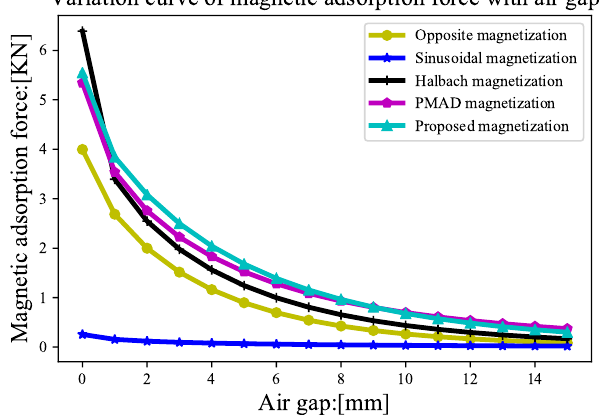
Figure 14. Effect of the magnetization mode on the magnetic adsorption force.